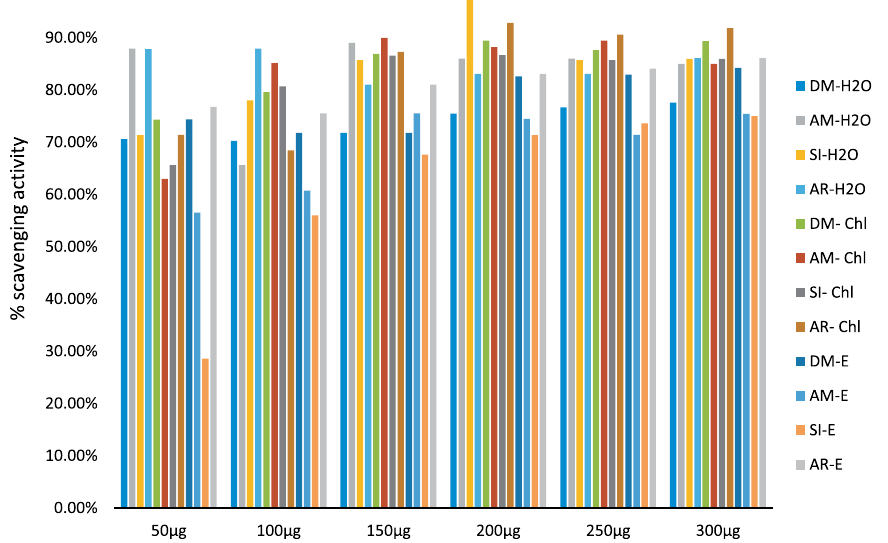
Fig. 6. Free radical scavenging activity of medicinal plants chosen for this study by DPPH assay.